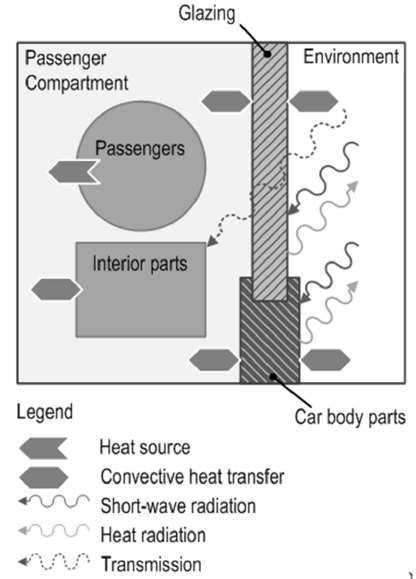
Figure 4. Simplified thermal model of the vehicle interior and designation of the heat flows considered. Source: author’s own illustration, adapted from Konz [39].